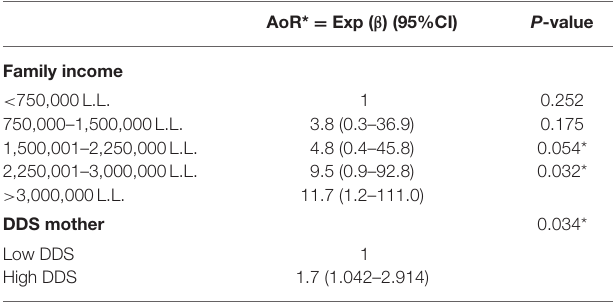
TABLE 4 | Association between the child’s dietary diversity score and the mother’s socio-demographic, education, and nutrition related factors.